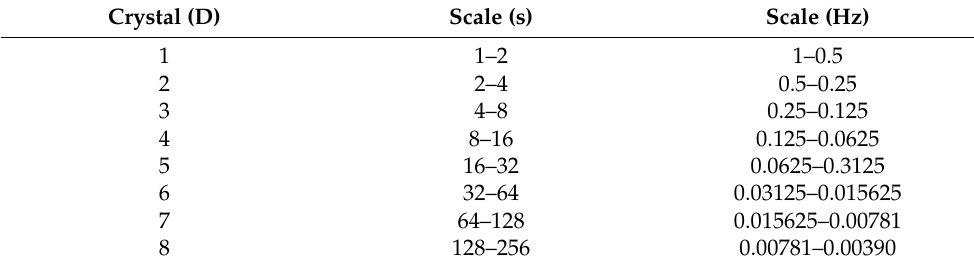
Table 6. Ranges of scale of each crystal.